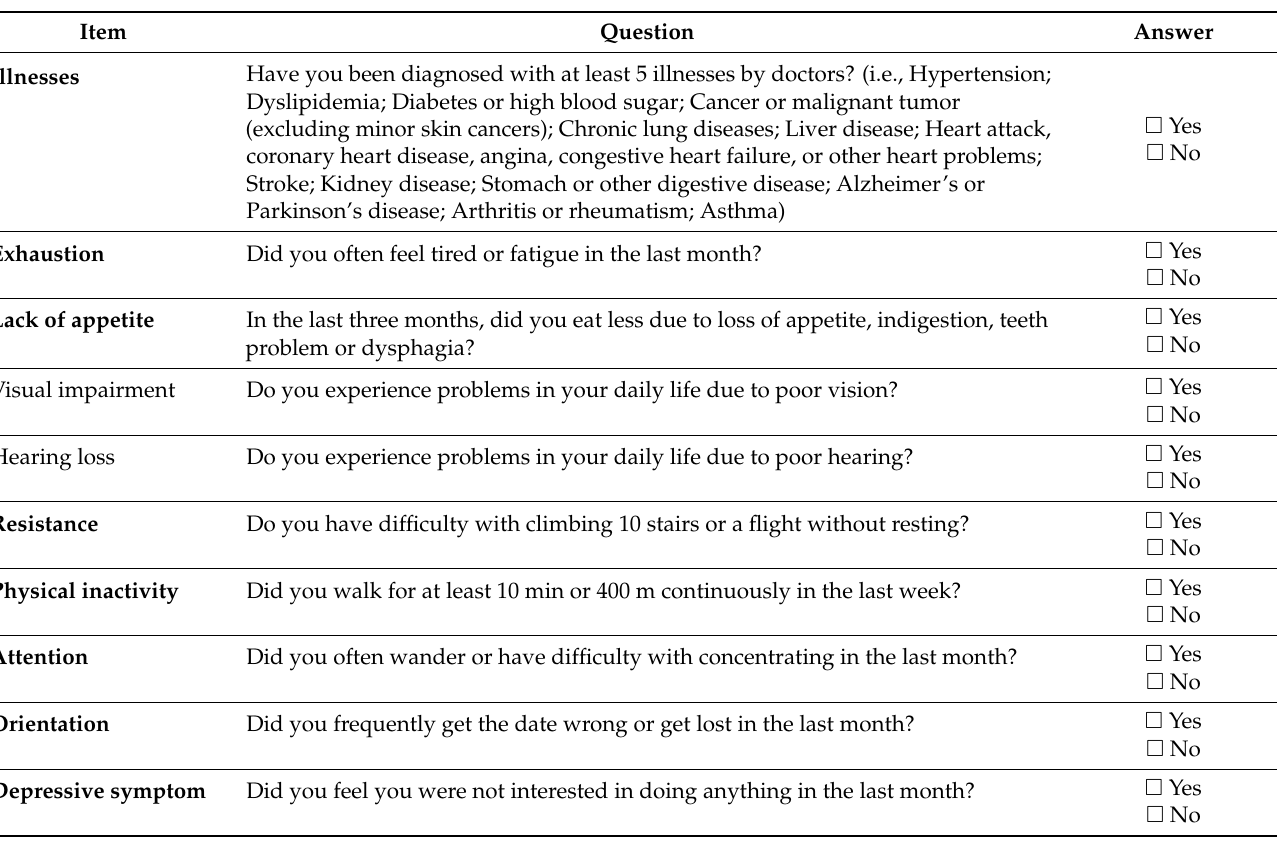
Table 2. The 10-item Chinese frailty screening scale (CFSS-10).